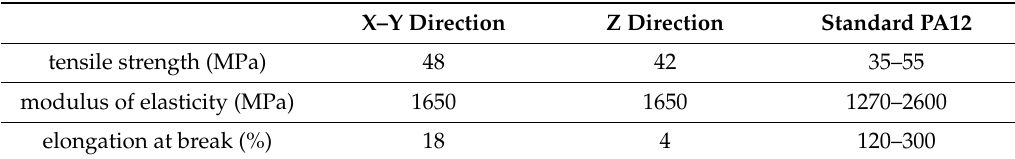
Table 1. Comparison of selected mechanical properties of 3D printing and a solid sample of PA12 material [18].